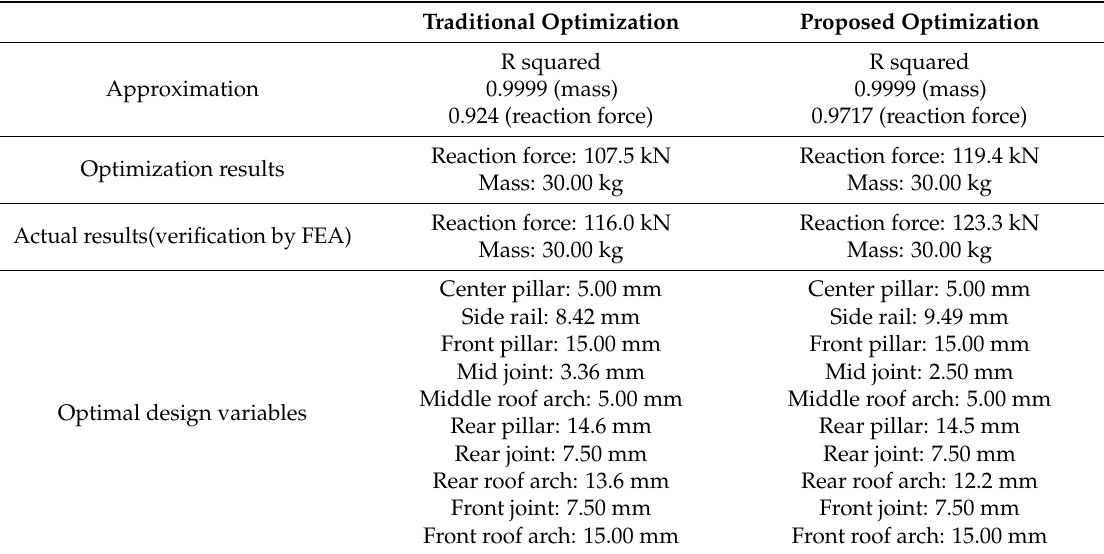
Table 6. Optimal design values and maximal reaction forces by traditional and proposed optimizations for the targeting mass of 30 kg using 5 strong clusters from 15 clustering types (case 6 in Table